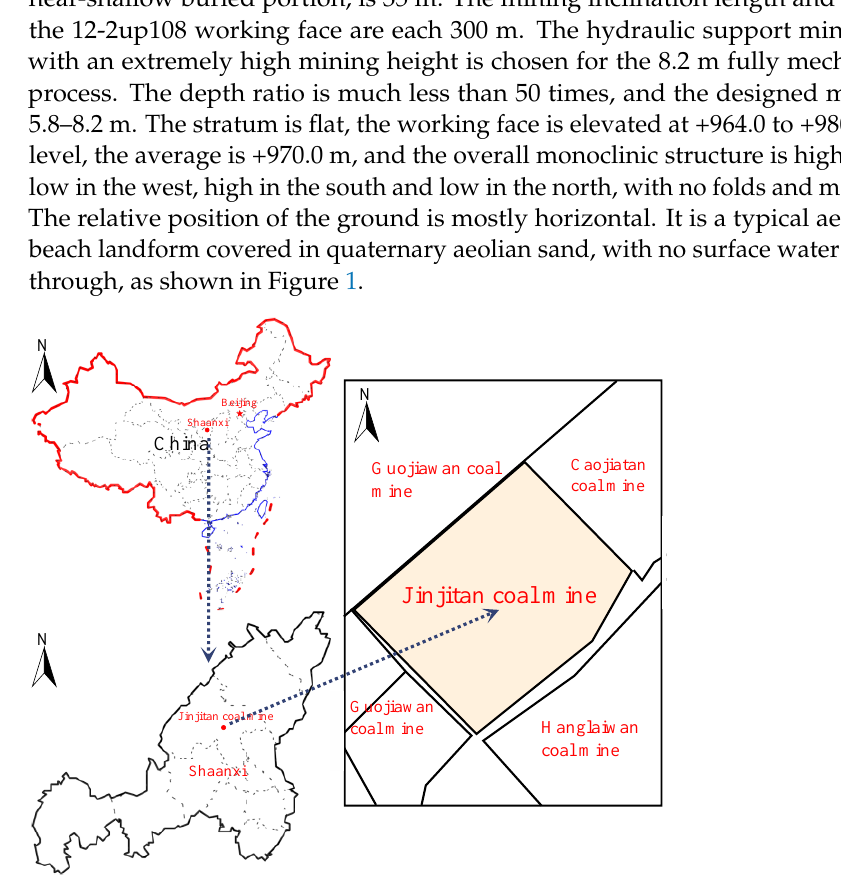
Figure 1. Location map of the Jinjitan coal mine.